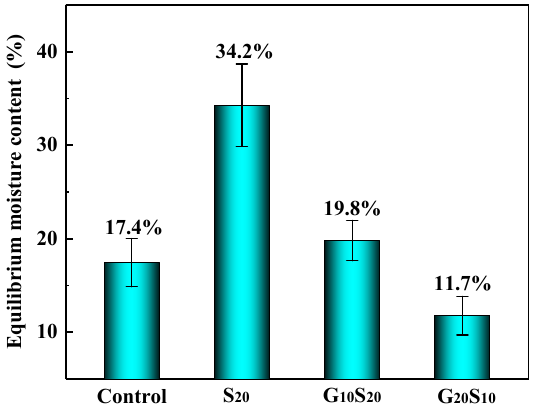
Figure 2. Equilibrium moisture content of the modified wood.